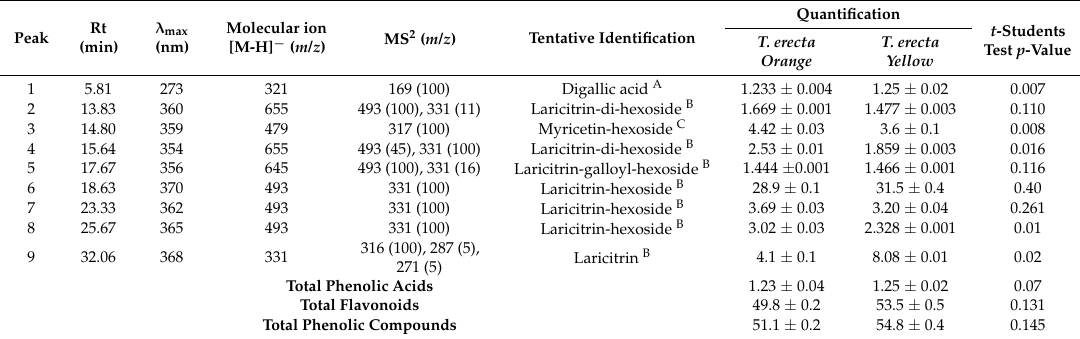
Table 1. Retention time (Rt), wavelengths of maximum absorption in the visible region ( λ , w), mass spectral data, tentative identification, and quantification (mg/g of extract) of the phenolic compounds present in orange and yellow cultivars of Tagetes erecta L. flowers.